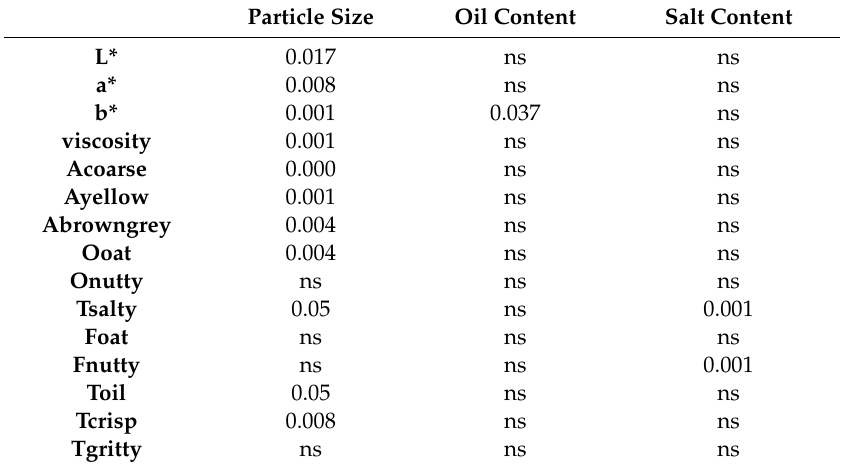
Table 6. Regression analysis showing the significant ( p ≤ 0.05) the main e ff ects of the parameters in the factorial